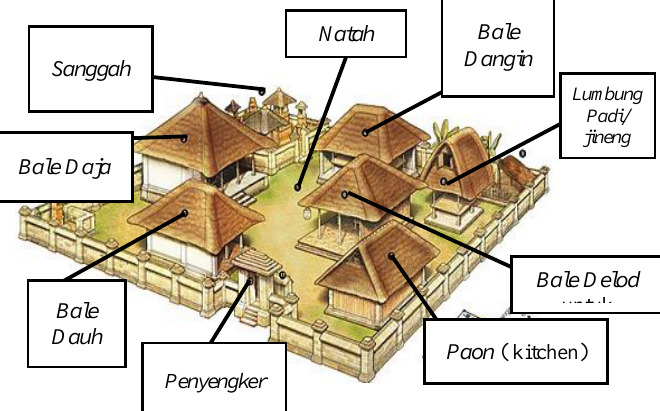
Figure 2. Illustration of traditional building in Bali.